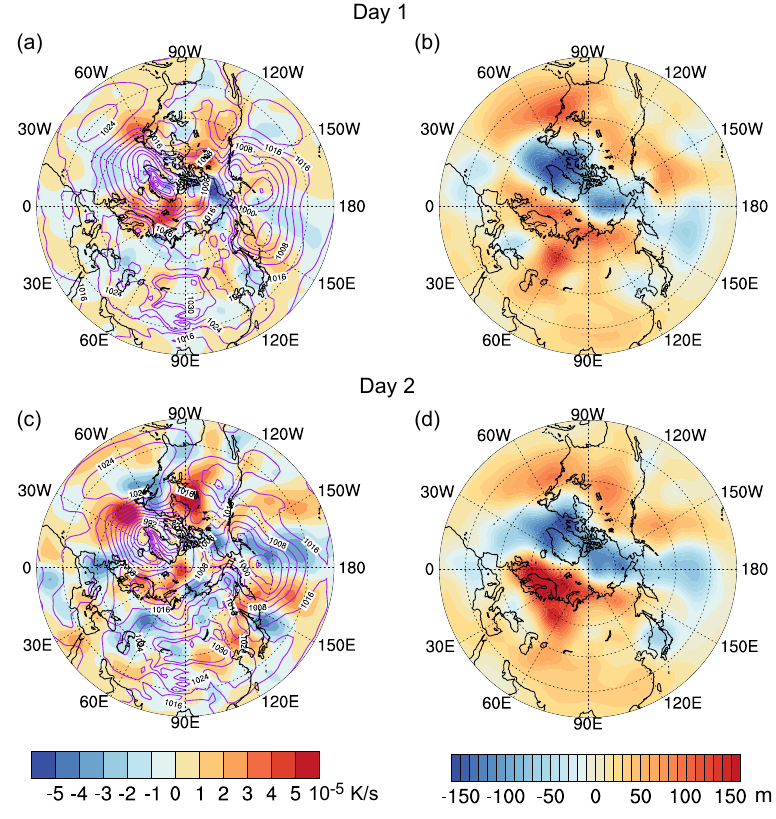
Figure 6. Composite ( a ) SLP (contours), 850hPa temperature advection (filled color), and ( b ) 500hPa geopotential height anomaly on large negative DET_CAI days and ( c , d ) that for fields on the next day,